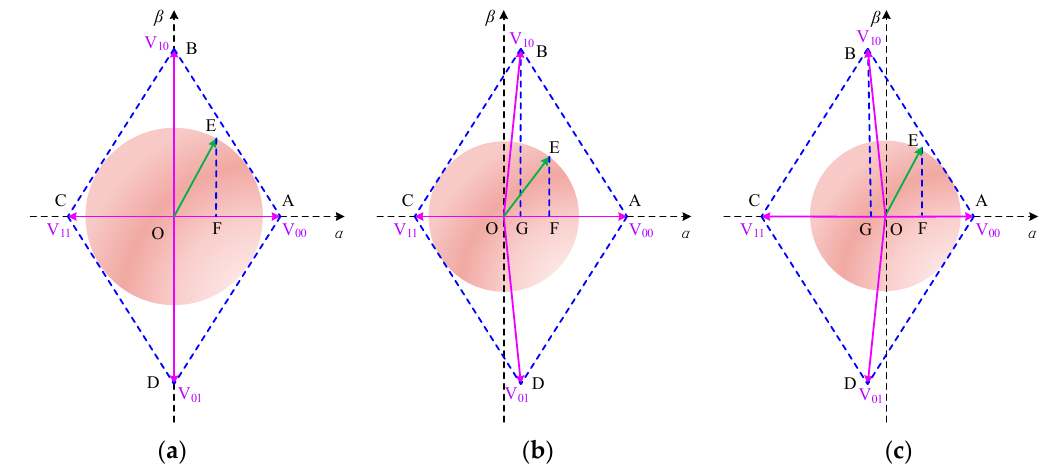
Figure 6. Space vector allocation for an FSTP converter with ( a ) V dc 1 = V dc 2 ( b ) V dc 1 < V dc 2 ( c ) V dc 1 > V dc 2 .